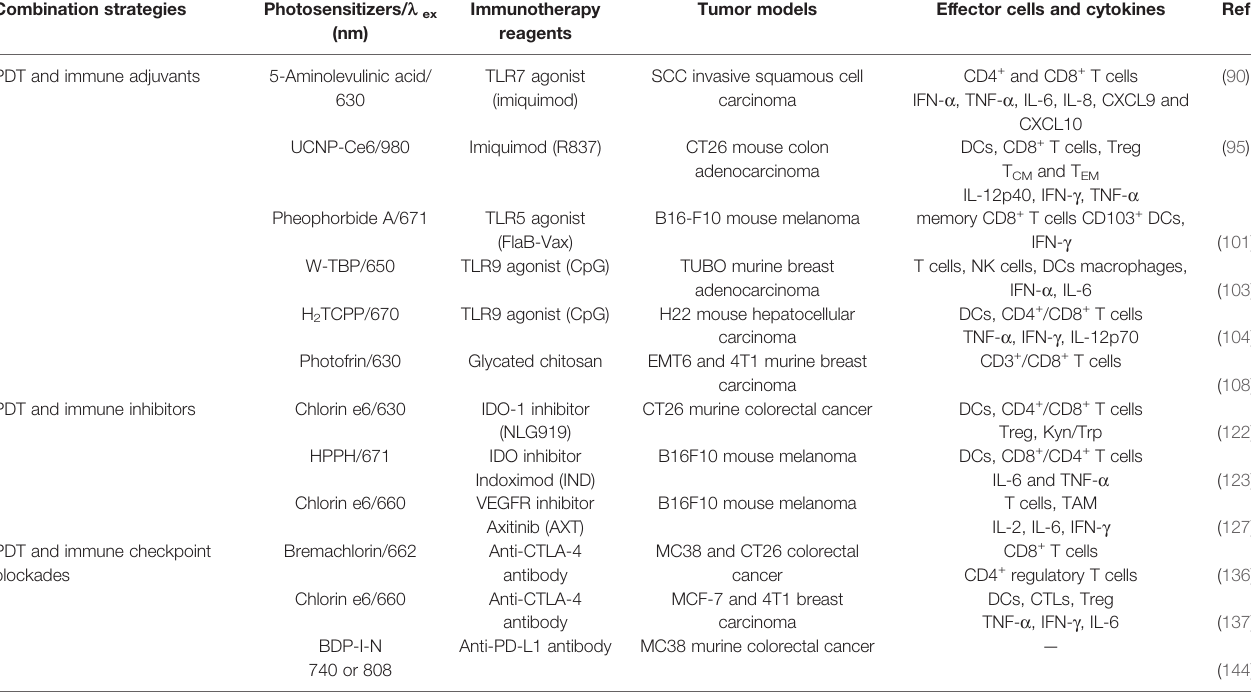
TABLE 1 | Summary of photodynamic therapy synergized